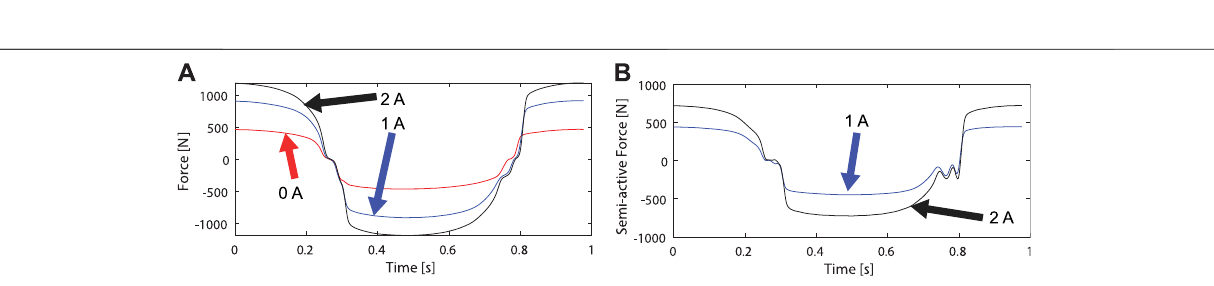
FIGURE15| Thetransientbehaviorofthedampingforcesinthespecimenfora5 mmexperiment,20 barinputpressureandthethreevaluesofelectriccurrent: (A) damping force f D for 0A, 1Aand 2A, (B) semi-active force due only to the electric current for 1Aand 2A(computed by subtraction) f D | 1 A , 20 Bar − f D | 0 A , 20 Bar , and f D | 2 A , 20 Bar − f D | 0 A , 20 Bar